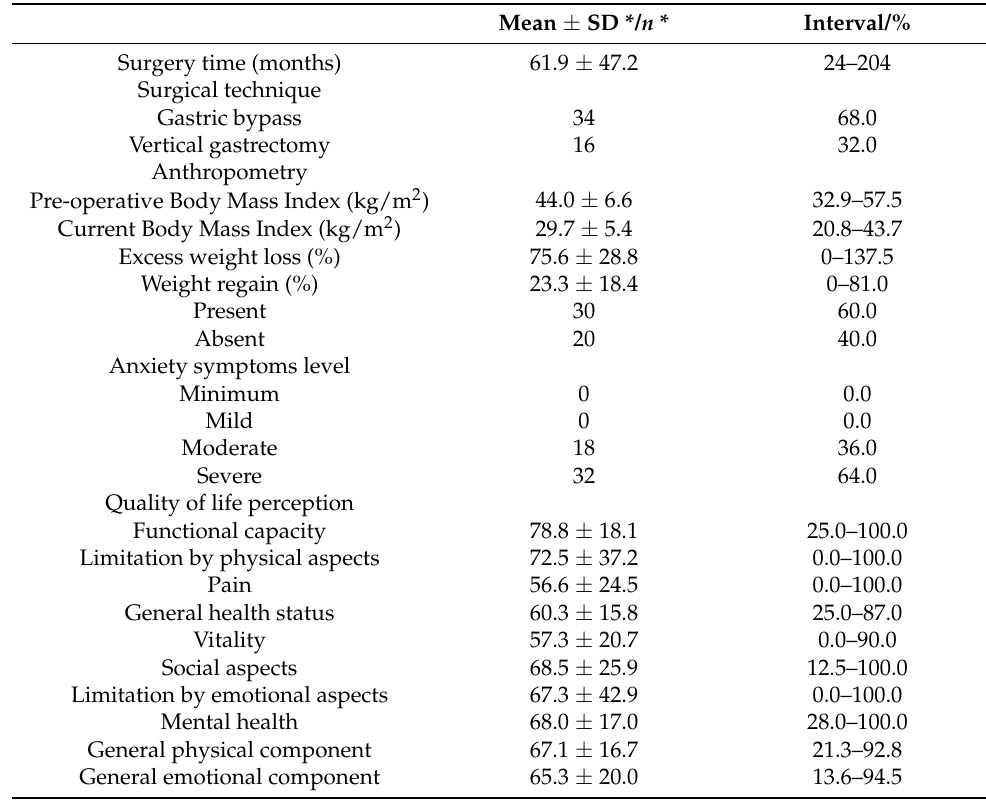
Table 1. Characterization of the clinical and anthropometric profile, anxiety symptoms, and percep- tion of quality of life of women more than 24 months after undergoing bariatric